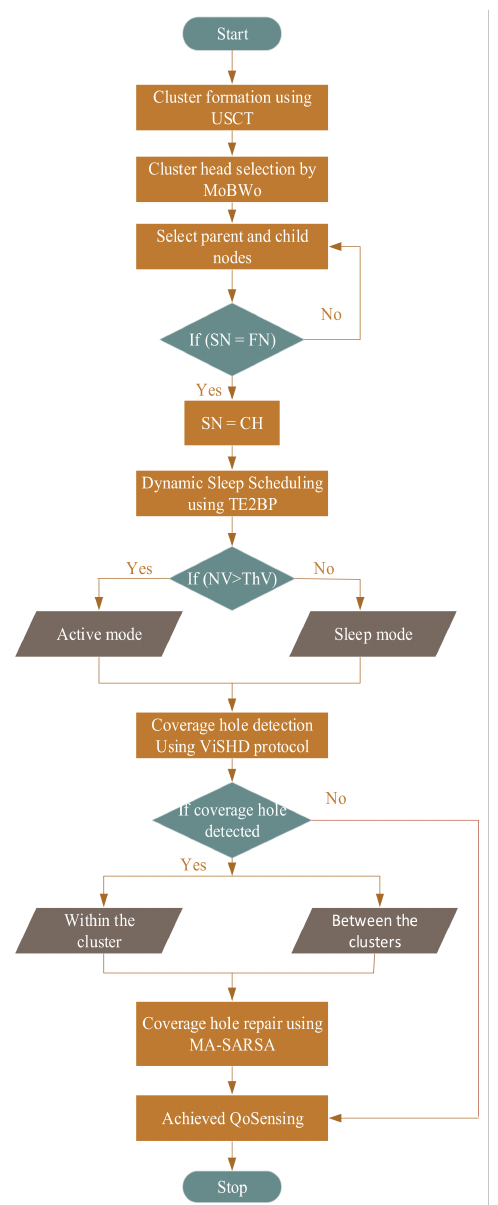
Figure 4. Flowchart of